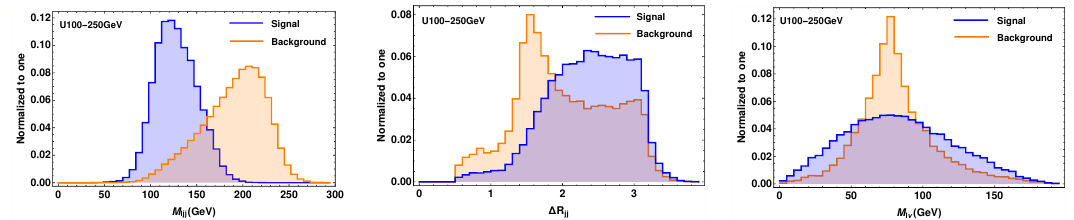
Figure 10 . Signal (blue) and background (orange) distributions for U100 model at a 250 GeV e + e (cid:0) collider: M ‘jj (left) after pre-selection cuts, (cid:1) R jj (middle) after M ‘jj cut, and M ‘(cid:23) (right) after (cid:1) R jj cut.